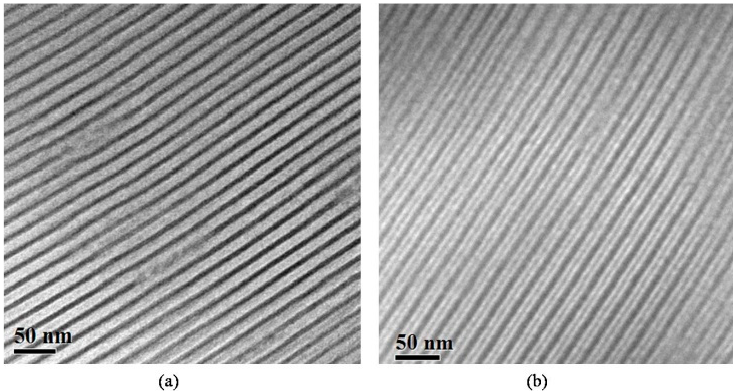
Figure 3. TEM images of the PB 1,4 - b -PS- b -PDMS terpolymer (sample 3). ( a ) Unstained sections where a two-phase alternating lamellae morphology is evident, with dark regions corresponding to PDMS and gray to the mixed PS/PB 1,4 segments, respectively. ( b ) Sections stained for 30 min with vapors of OsO 4 , leading to a distinct three-phase four-layer alternating lamellae structure, as in sample 1, where the block sequence is different. Black corresponds to PB, white to PS and dark gray to PDMS domains.